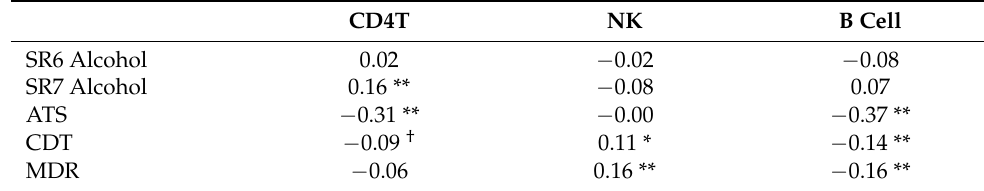
Table 6. Pearson correlation coefficients of alcohol consumption markers with predicted cell